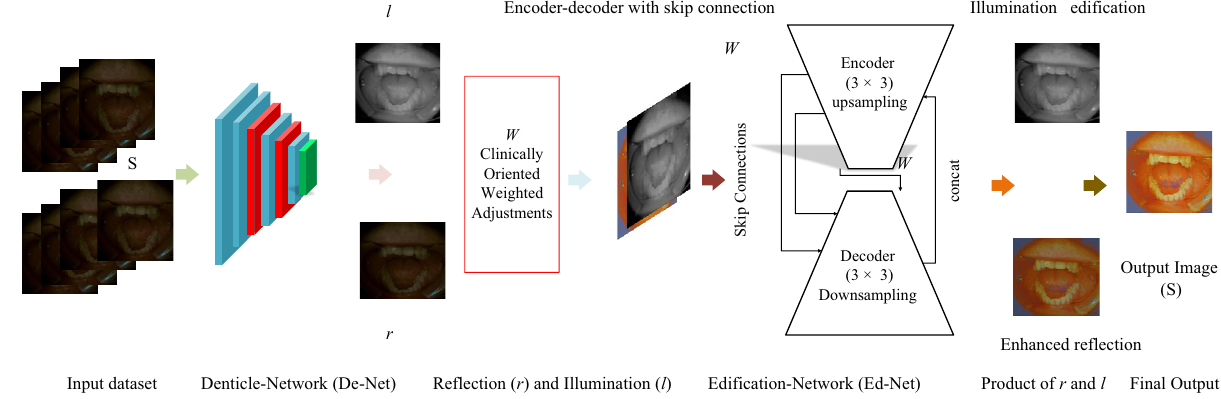
Figure 1. Framework of the proposed Denticle Edification network